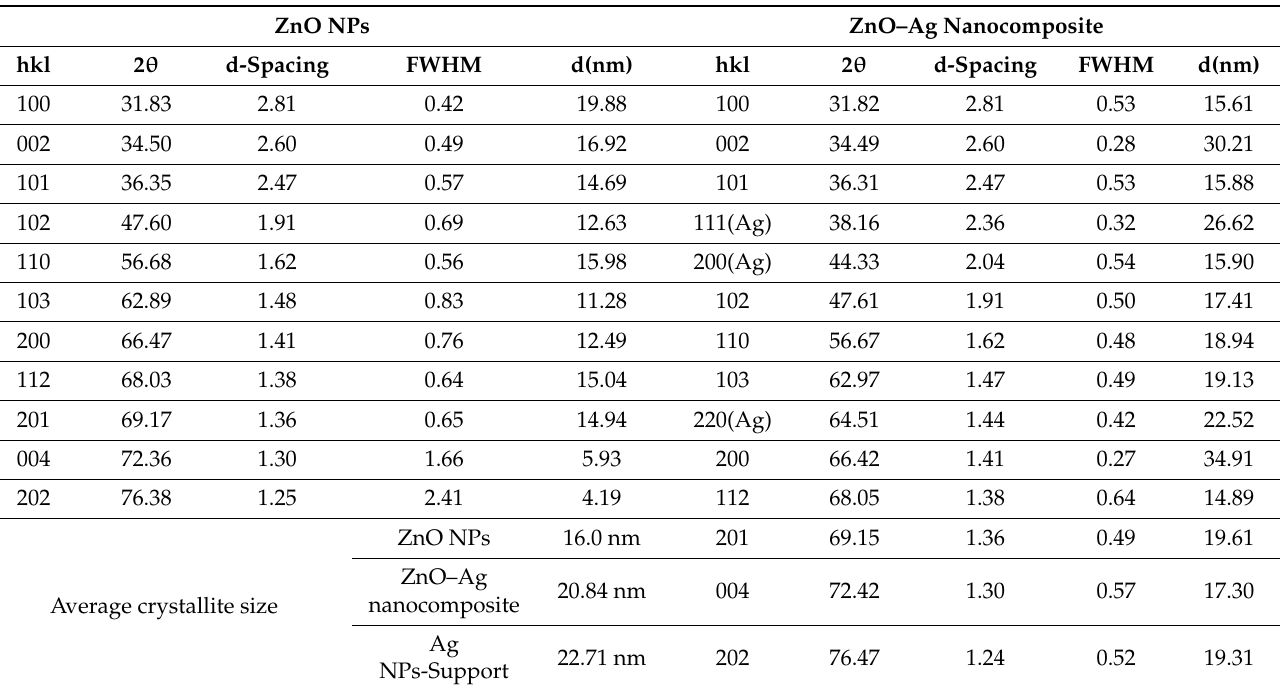
(53.46 %), O (28.75%), Ag (14.91%), and C (2.88%) [28]. At the same time TEM analysis of